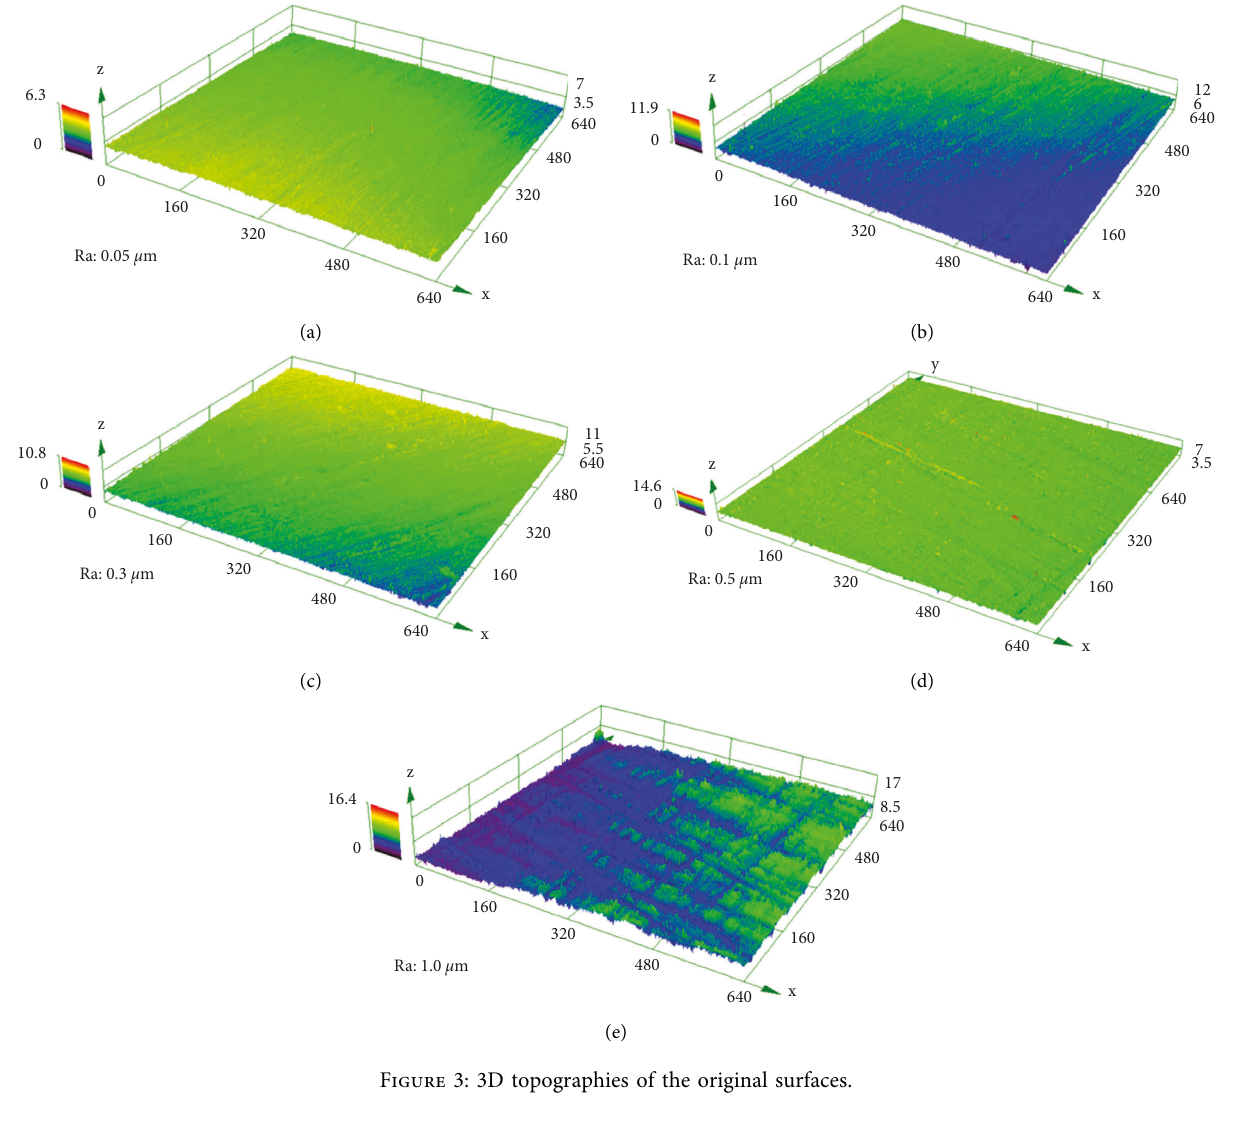
Figure 3: 3D topographies of the original